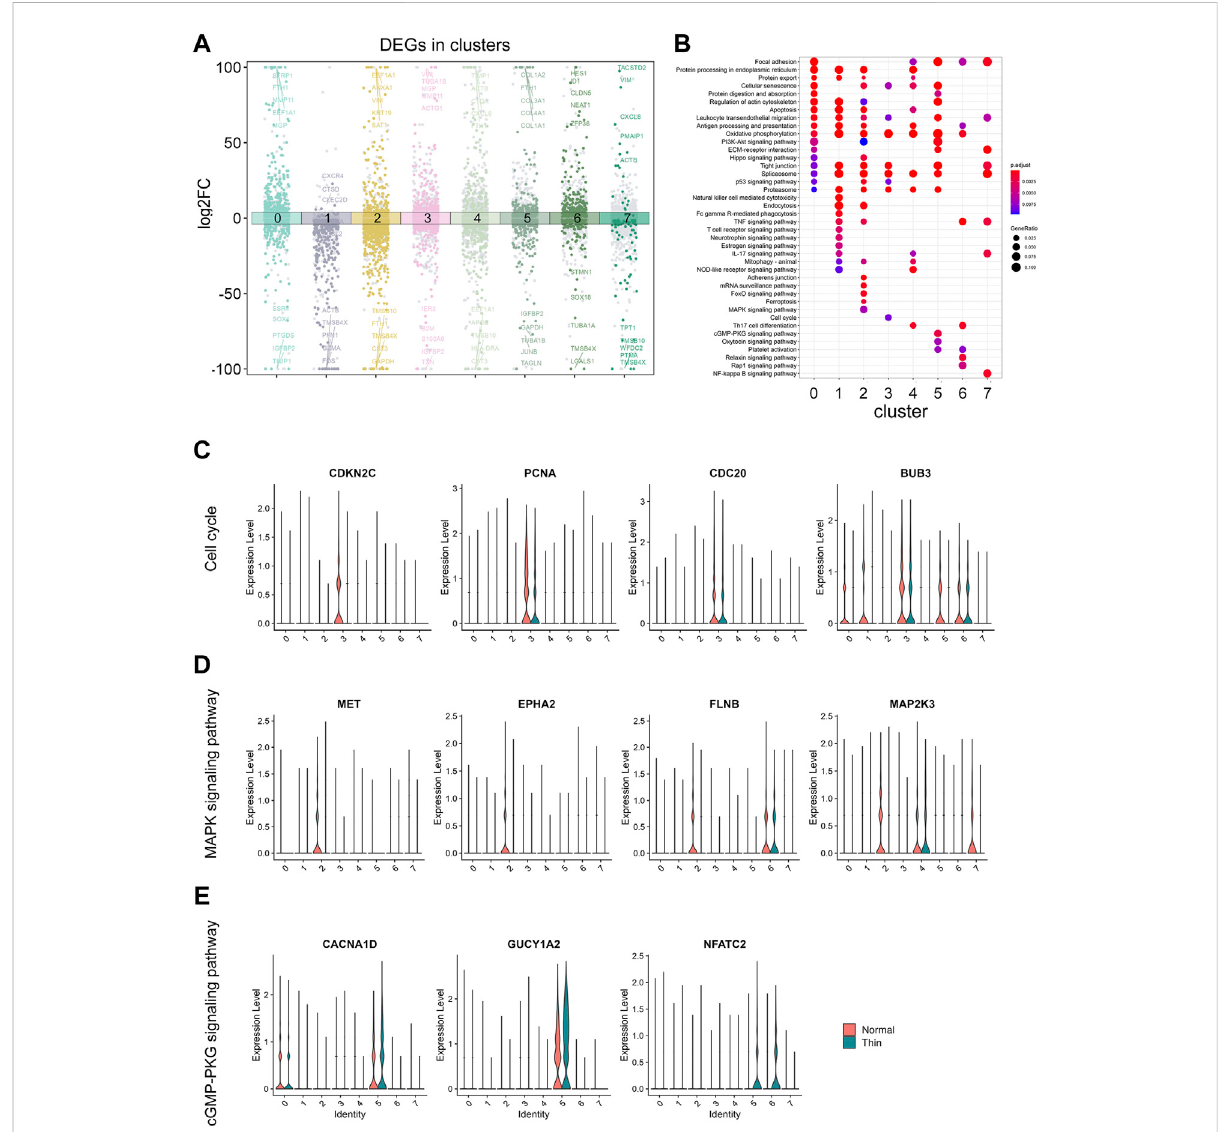
FIGURE 3 TheanalysisforDEGsinclustersandunderthinendometriumcondition. (A) Dotplotshowingtheup-anddownregulatedgenesacrossalleight clusters in thin endometrial tissue. The DEGs were colored by clusters and labeled by the top5 up- and downregulated DEGs in each cluster. (B) KEGG enrichment of upregulated and downregulated DEGs across clusters. Violin plot showing the expression level of genes in enriched KEGG pathways: cell cycle (C) , MAPK signaling pathway (D) , and cGMP- PKG signaling pathway (E) .